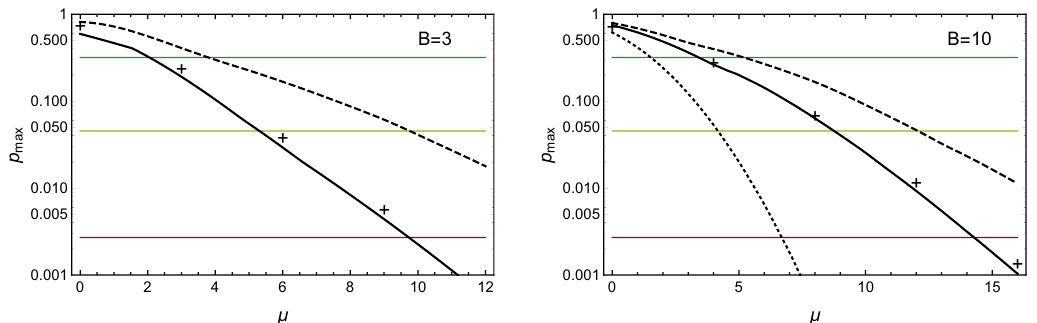
Figure 4 . The expected p -value, computed at the median over 100 toy Monte Carlos, for B = 3 (left) and B = 10 (right). The crosses represent the ideal p -value, continuos, dashed and dotted lines represent the full, the (cid:31) 2 and the modi(cid:12)ed (cid:31) 2 tests, respectively. The levels of p -value corresponding to 1, 2 and 3 (cid:27) are also